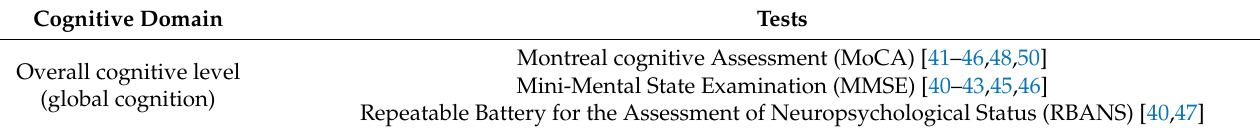
Table 3. Tests and cognitive domains